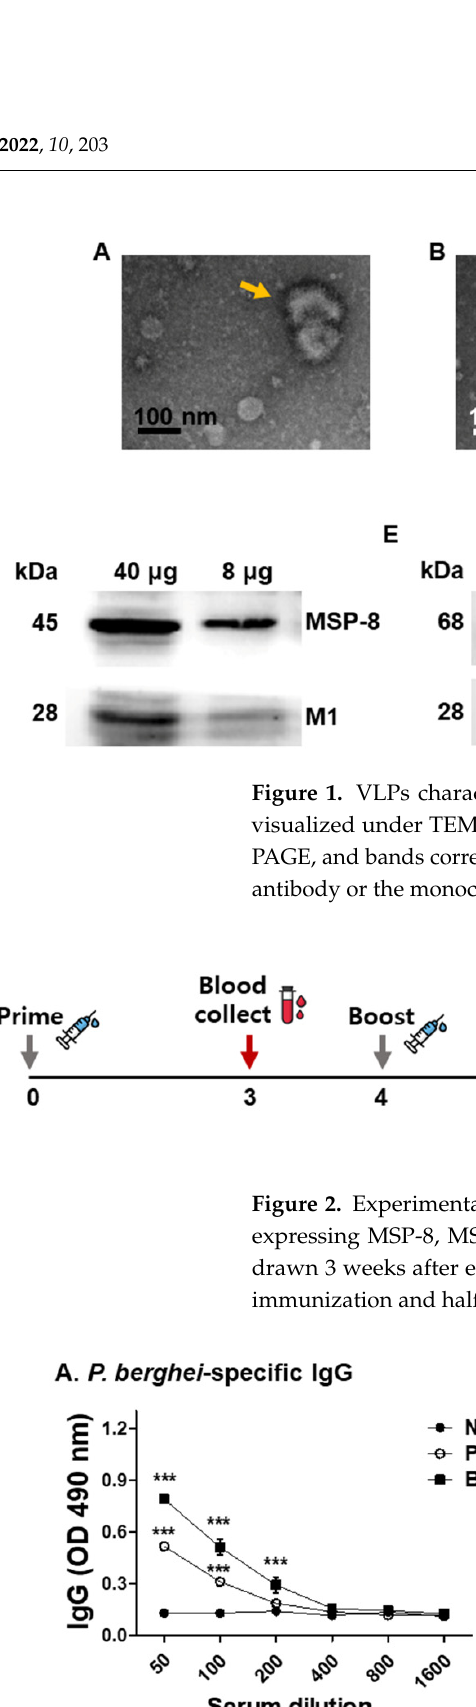
Figure 2. Experimental schedule. Mice were immunized twice with the combined VLP vaccines ex- pressing MSP-8, MSP-9, and RAP1 of P. berghei at 4 weeks intervals, and blood samples were drawn 3 weeks after each immunization. Challenge infection was performed 4 weeks after boost immun- ization and half of the mice in each group were sacrificed at 1 week post-challenge.